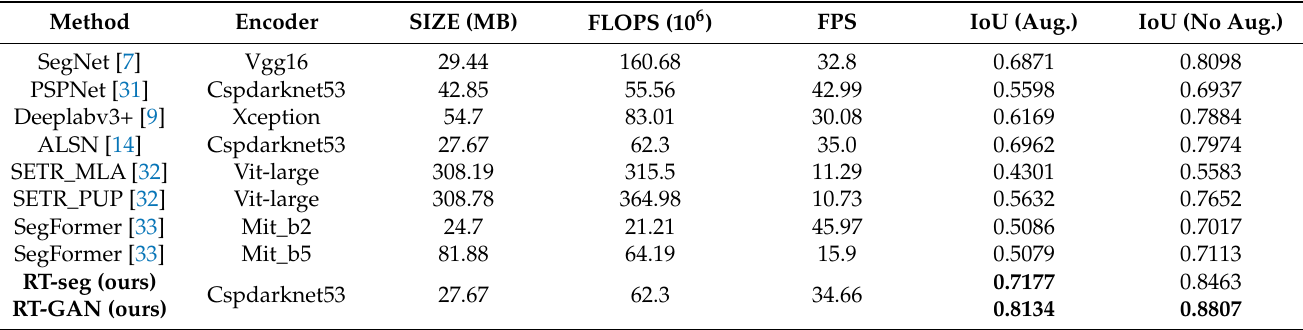
Table 2. Performance comparison of